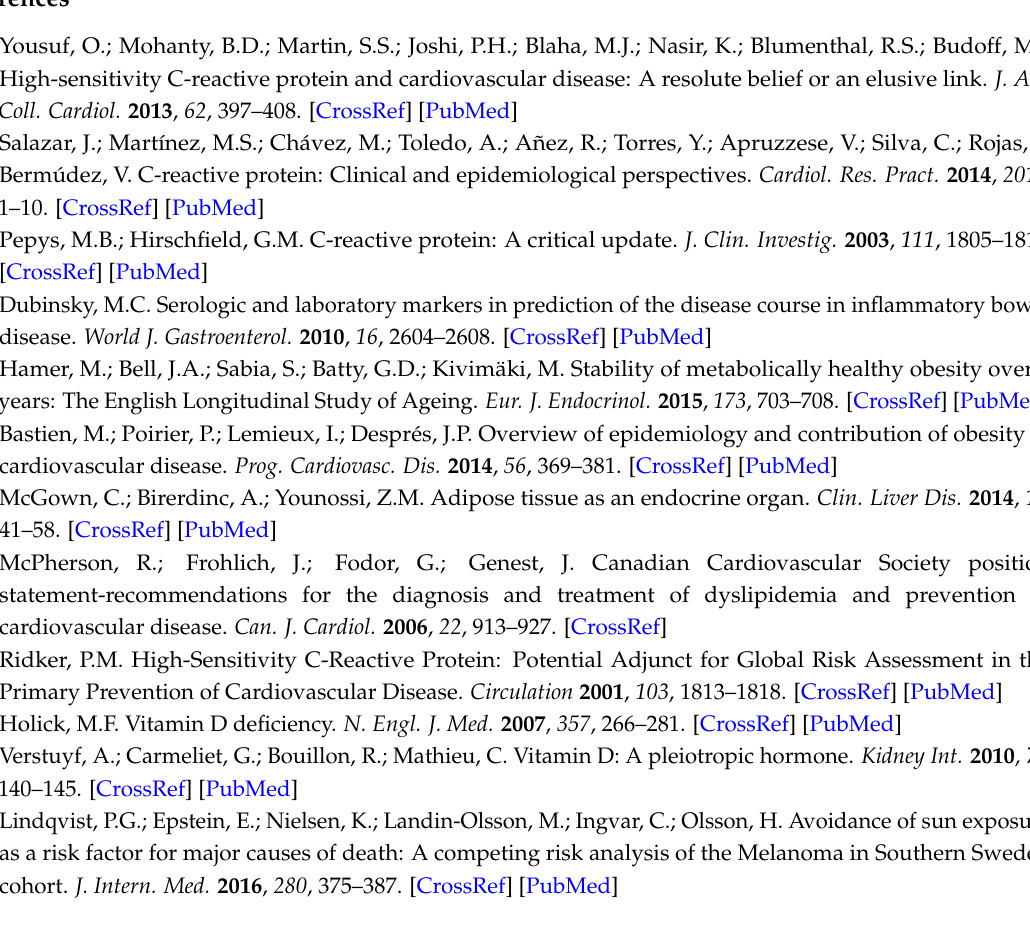
Table S1: Risk for elevated C-reactive protein concentration ( ≥ 3 mg/L) at follow-up by body weight status at